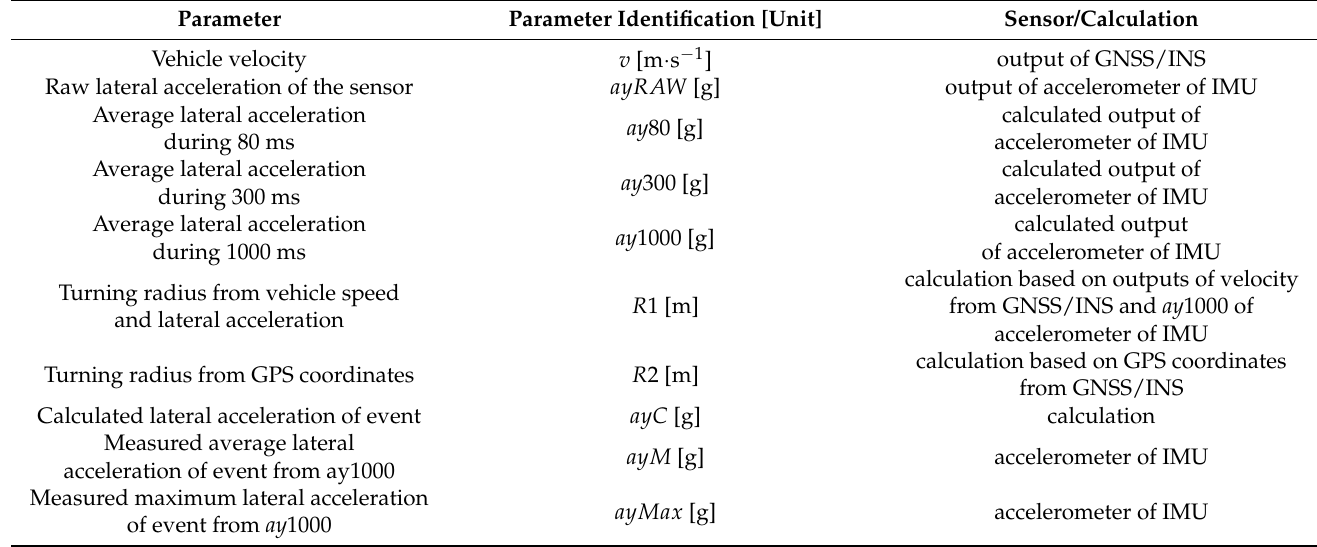
Table 2. Measured and calculated parameters and sensors of GNSS/INS sensor